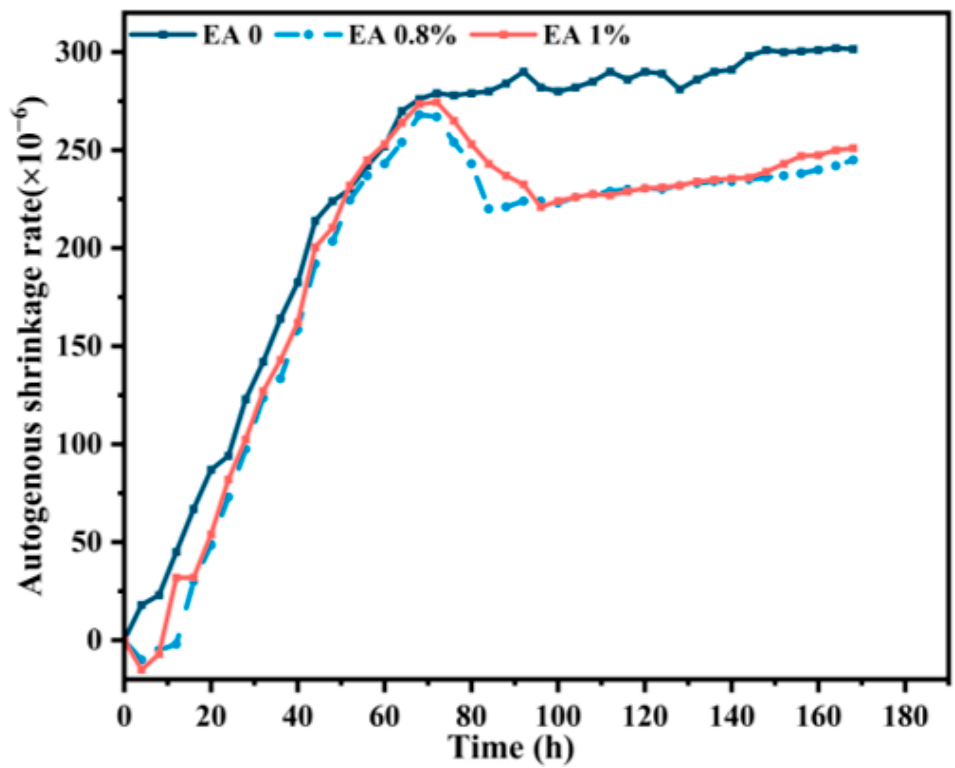
Figure 6. Influence of expansive agent content on the autogenous shrinkage of PMJC (PMJC17, PMJC19, and